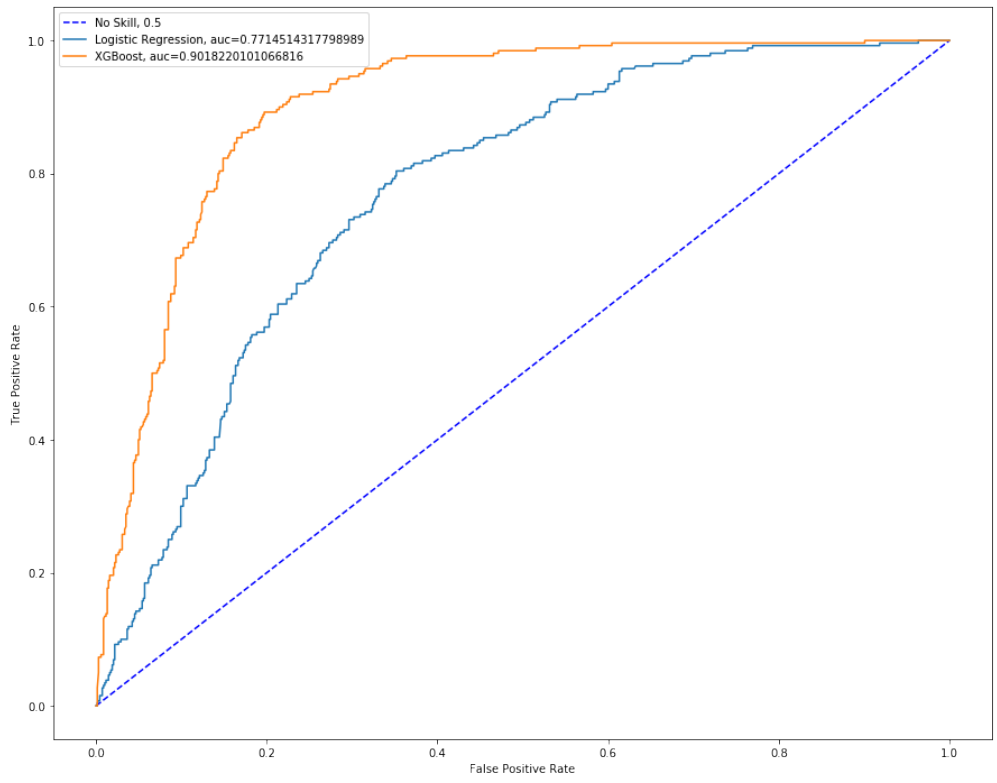
Figure 1. ROC curves